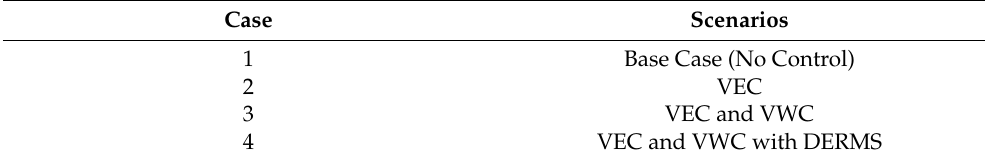
Table 5. Simulation scenarios.